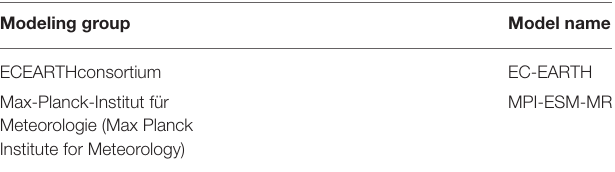
at the western entrance of the Strait were extracted from the nearest node of the driven GCM for each simulation (see below) while the rest of the water column temperature was not changed.